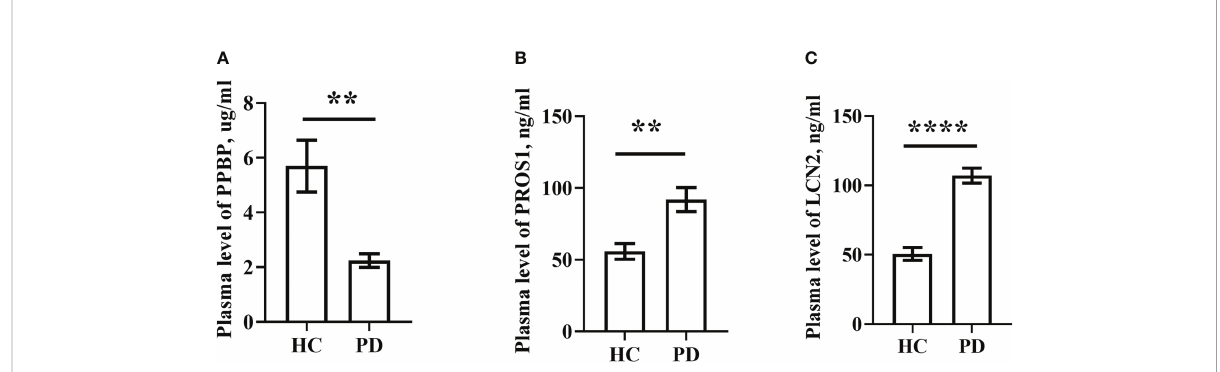
FIGURE 9 Plasma levels of PPBP, PROS1 and LCN2 in PD patients (n=69) and healthy controls (n=36). (A) Comparison of the expression levels of plasma PPBP; (B) Comparison of the expression levels of plasma PROS1; (C) Comparison of the expression levels of plasma LCN2. HC represents